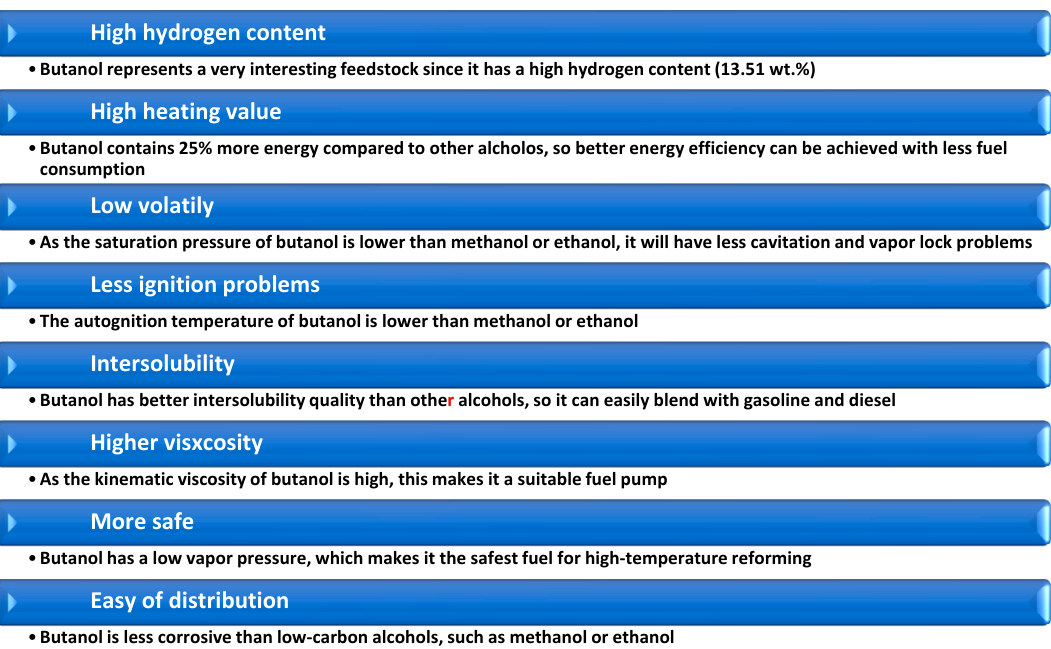
Figure 21. Advantages of using butanol [259].